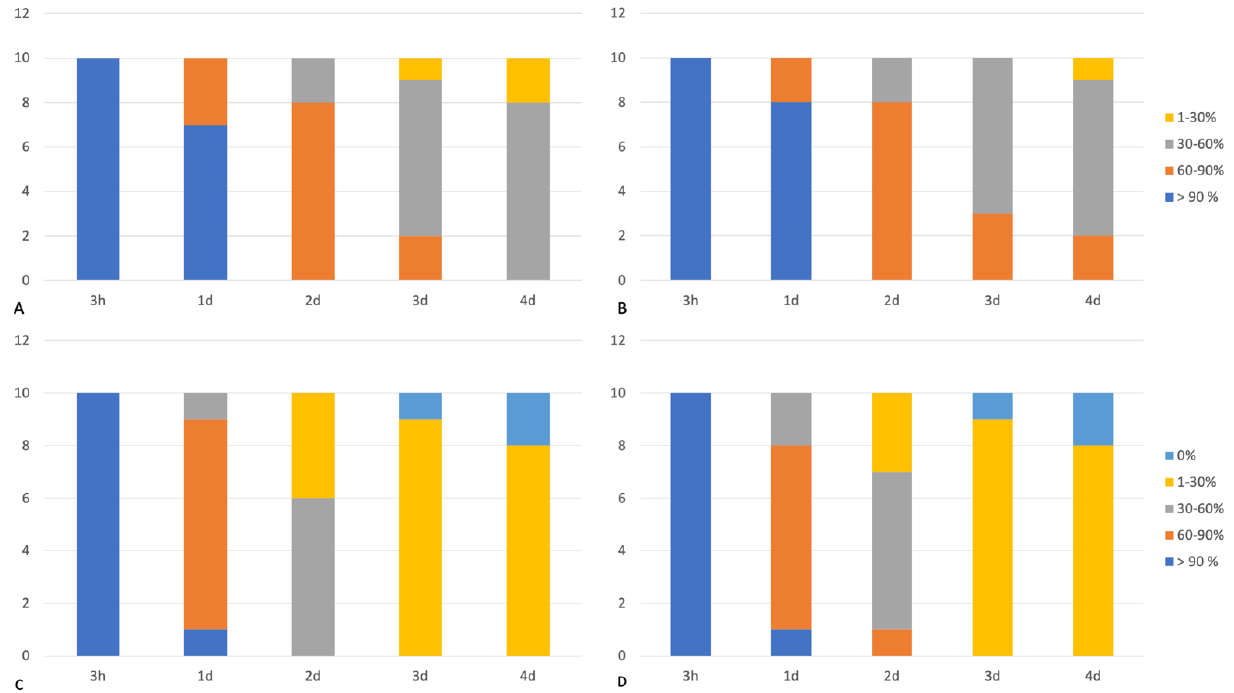
Figure 3. The percentage of positive fibers for each assessed group. (A) Desmin-positive fibers in triceps brachii muscles , (B) desmin-positive fibers in vastus lateralis muscles; (C) dystrophin-positive fibers on triceps brachii muscles; (D) dystrophin-positive fibers in vastus lateralis muscles .